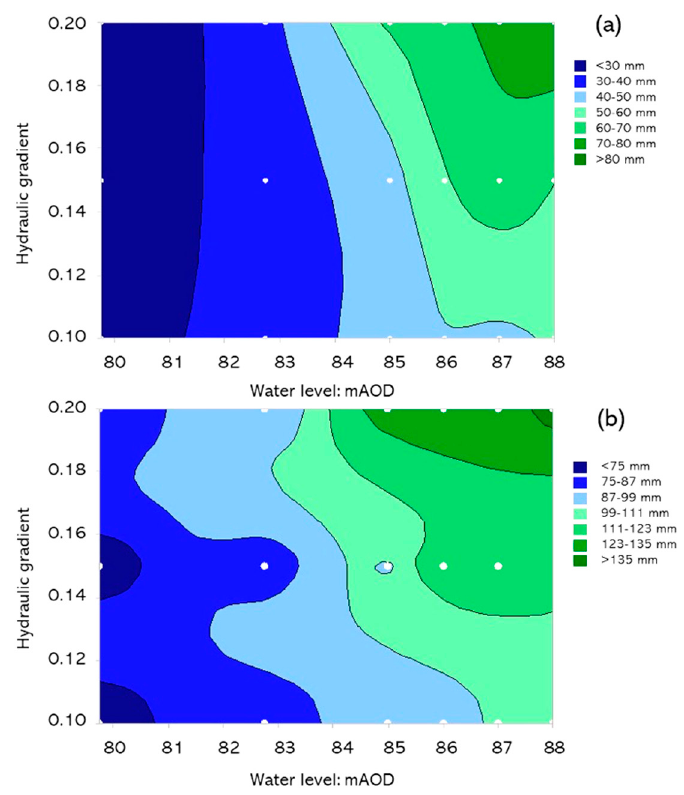
Figure 6. Impact on the lateral displacement of the water level and hydraulic gradient; ( a ) displacement at the reflector level (97 mAOD, near crest), ( b ) maximum displacement.